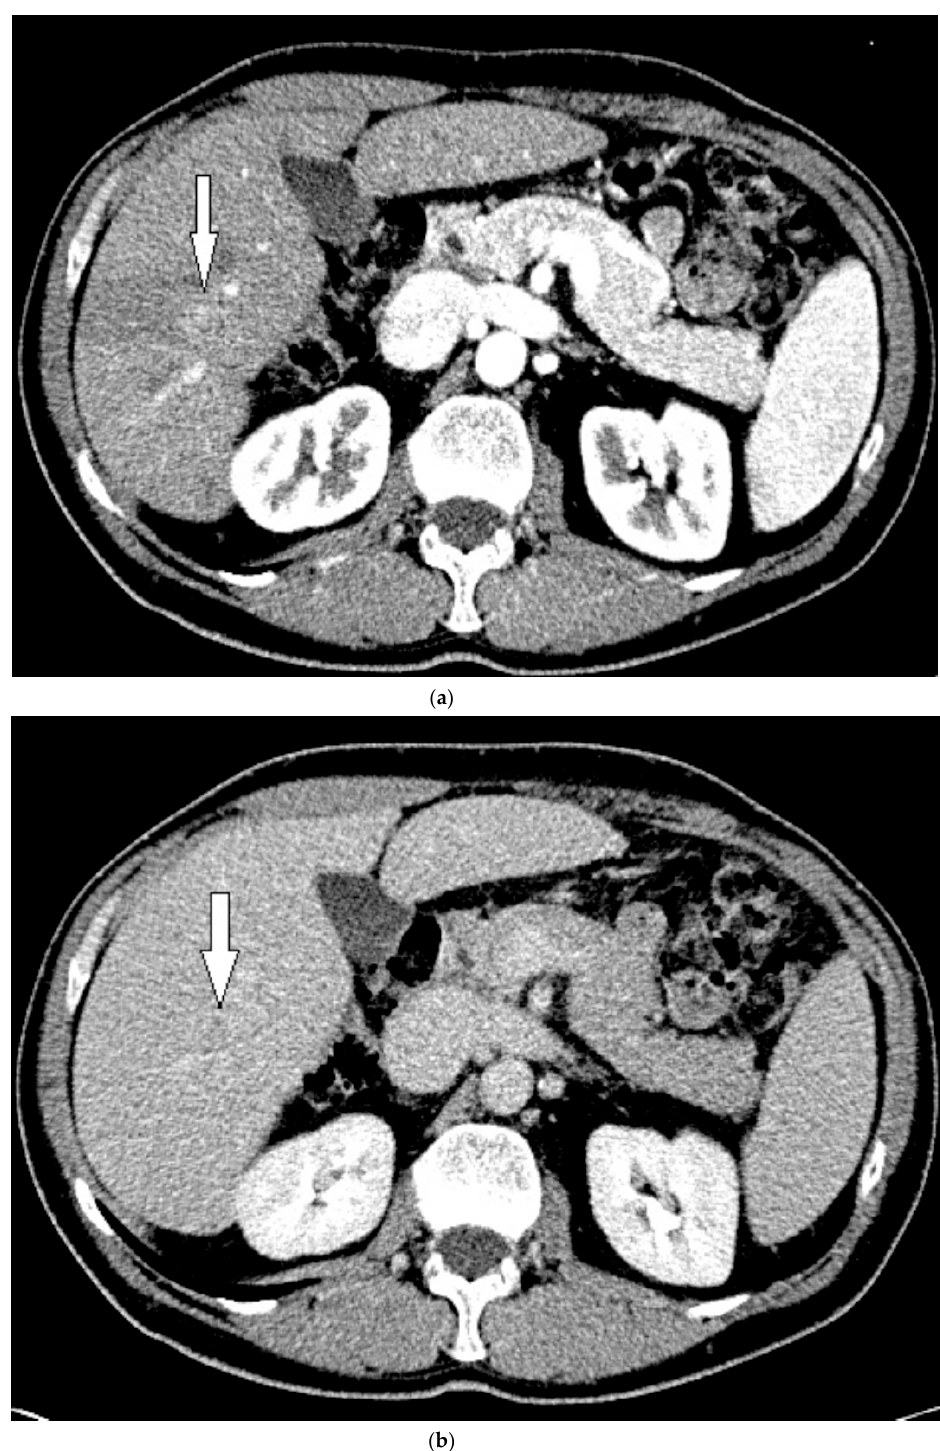
Figure 2. Patient 1 CT images using liver windows to highlight the subtle lesion easily seen on contrast-enhanced ultrasound (CEUS) (white arrow): ( a ) late arterial phase axial contrast-enhanced CT; ( b ) 3 min delayed